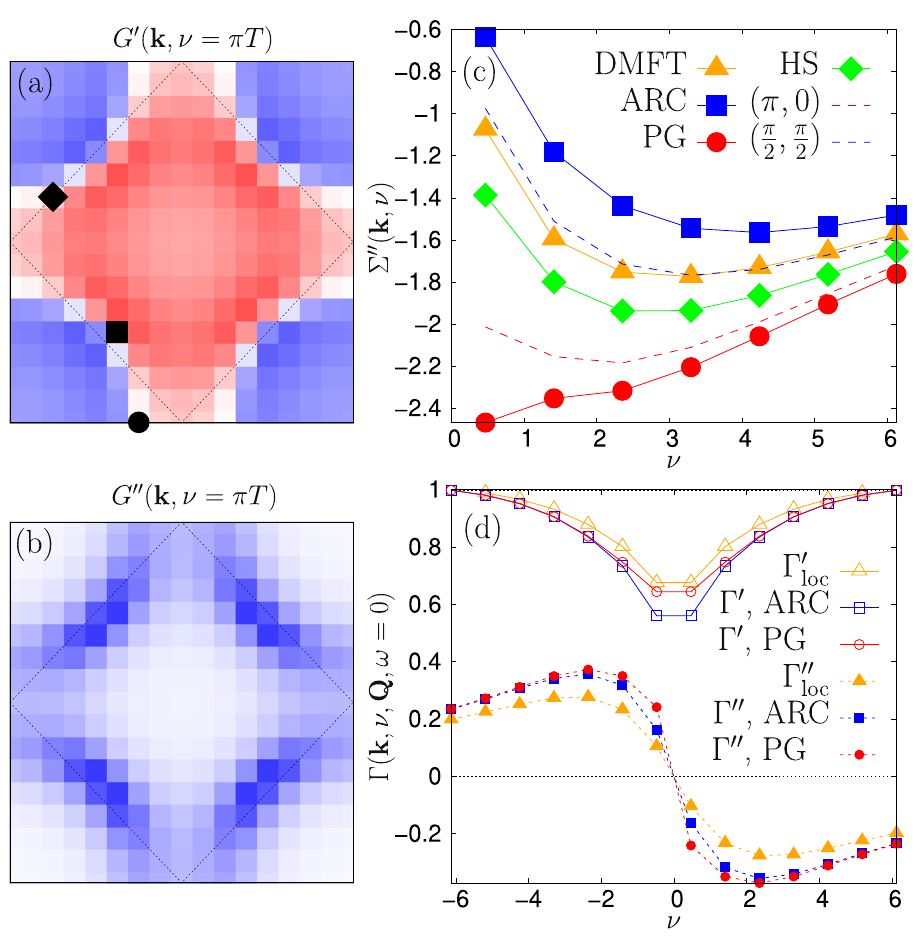
Fig. 3 Green ’ s function, self-energy, and spin-fermion vertex in the pseudogap regime. a Real and b imaginary part of the Matsubara Green ’ s function G for doping δ = 0.01 (here, and in all fi gures, interaction U = 8 t , next- and next-next-nearest neighbor hopping t 0 ¼ (cid:2) 0 : 2 t , t ″ = 0.1 t , respectively). The correlation length is ξ ≈ 1.6. Black symbols mark Fermi arc (ARC), pseudogap (PG), and hot spot (HS) momentum on the FS. c Self-energy and d static spin-fermion vertex Γ ( Q , ω = 0) at these and further fermionic momenta as a function of the Matsubara frequency ν . Triangles show local dynamical mean- fi eld (DMFT) quantities.